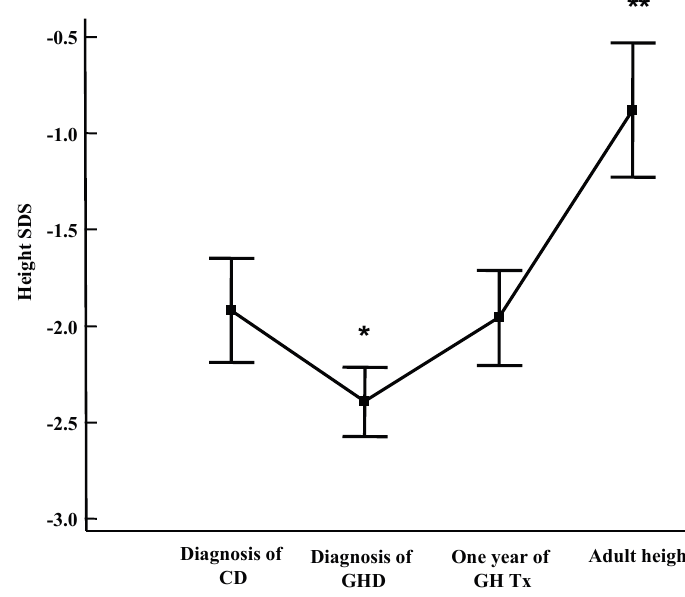
Figure 3. Height Standard Deviation Score (SDS) in CD-GHD patients at CD diagnosis, at GHD diagnosis, after 1 year of GH replacement therapy and at final height. Results are expressed as mean ± SEM (Standard Error of Mean)